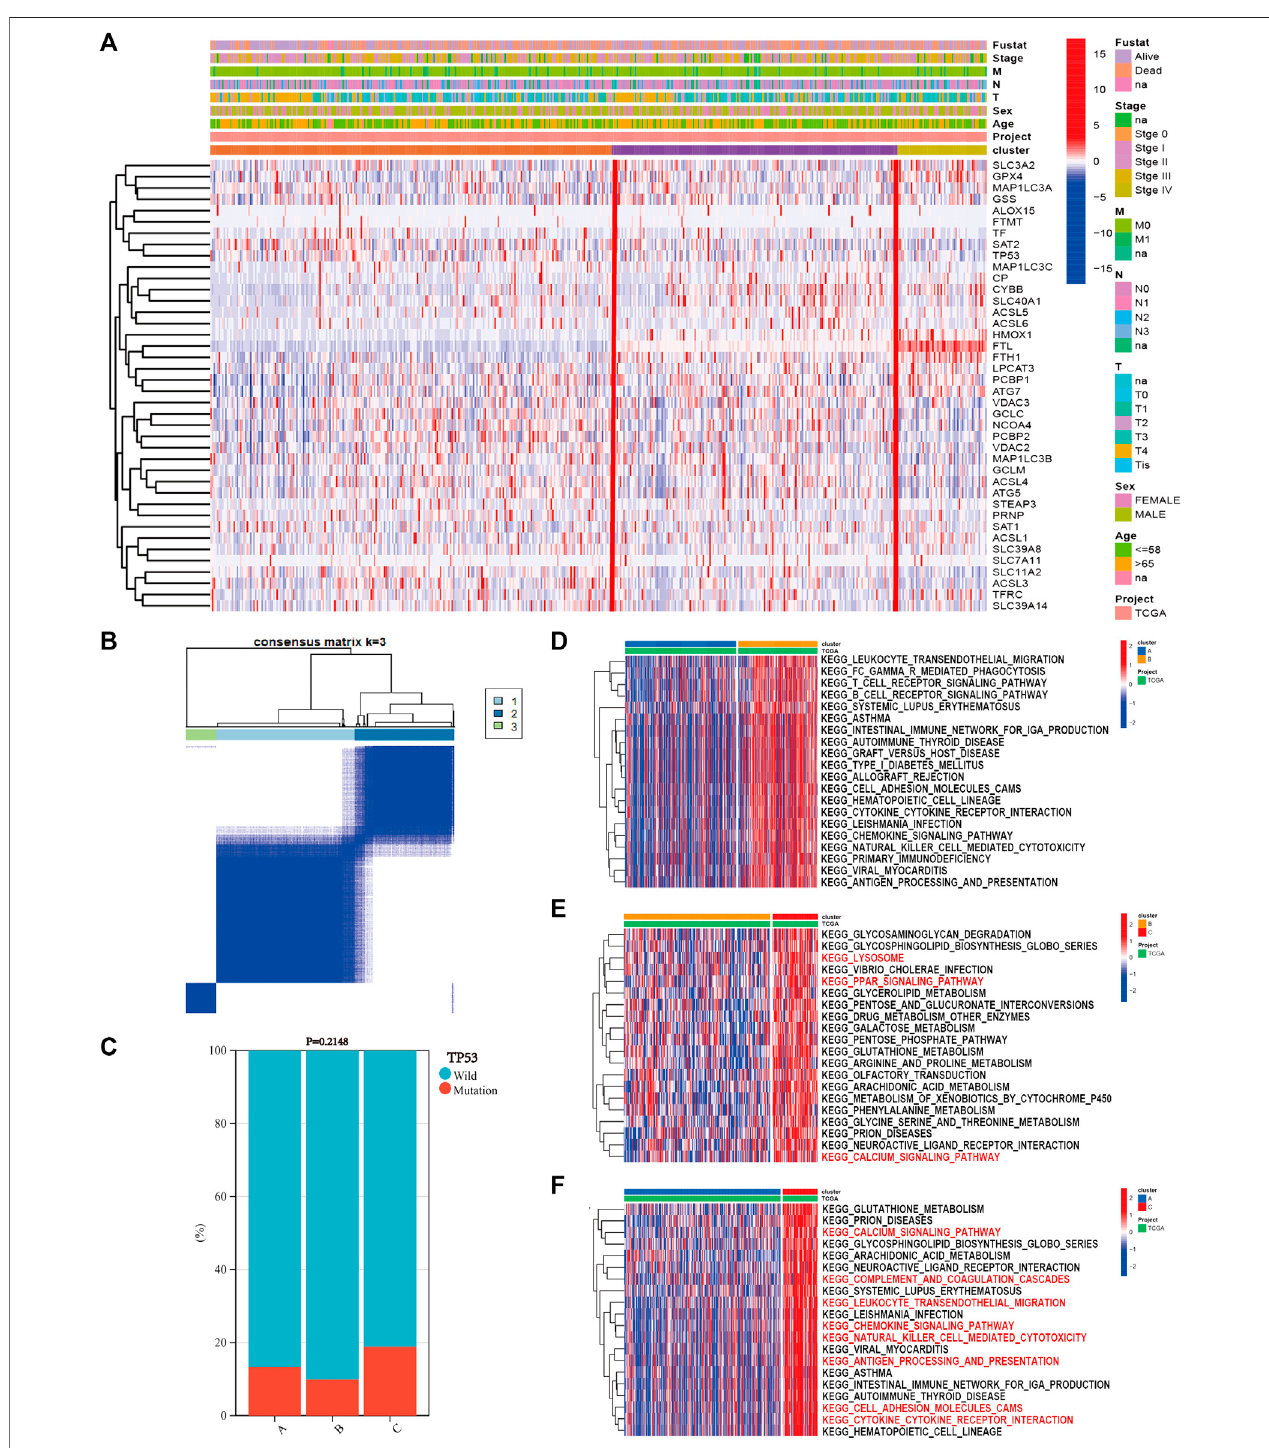
FIGURE2| Theresultsofconsensusclusteringofferroptosis-relatedgeneswithgeneset variationanalysis(GSVA)enrichment analysis. (A) Theheatmapshowed the detailed clinicopathological features of skin cutaneous melanoma (SKCM) patients in each cluster. (B) SKCM patients were divided into three clusters according to the consensus clustering ( k (cid:1) 3). (C) TP53 mutation state in each cluster. GSVA enrichment analysis revealed the top 20 signi fi cant biological pathways between every two clusters: (D) cluster A vs. cluster B, (E) cluster B vs. cluster C, and (F) cluster A vs. cluster C.